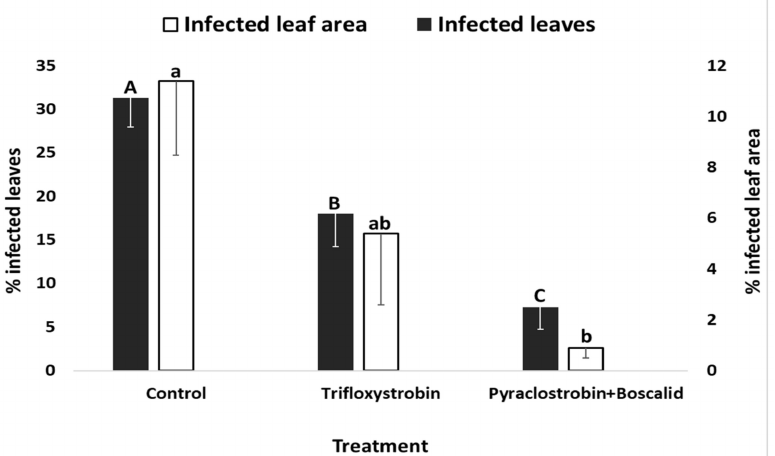
Figure 5. Activity of the strobilurin fungicide trifloxystrobin at 0.015% ( w/v ) and the prepacked mixture Bellis at 0.05% (containing pyraclostrobin + boscalid) on apple scab development in the Alonei Ha’bashan orchard in 2015. Bars represent the standard error of the mean. Different letters on the bars indicate significant differences ( p < 0.05) according to Fisher’s LSD K-ratio t -test.